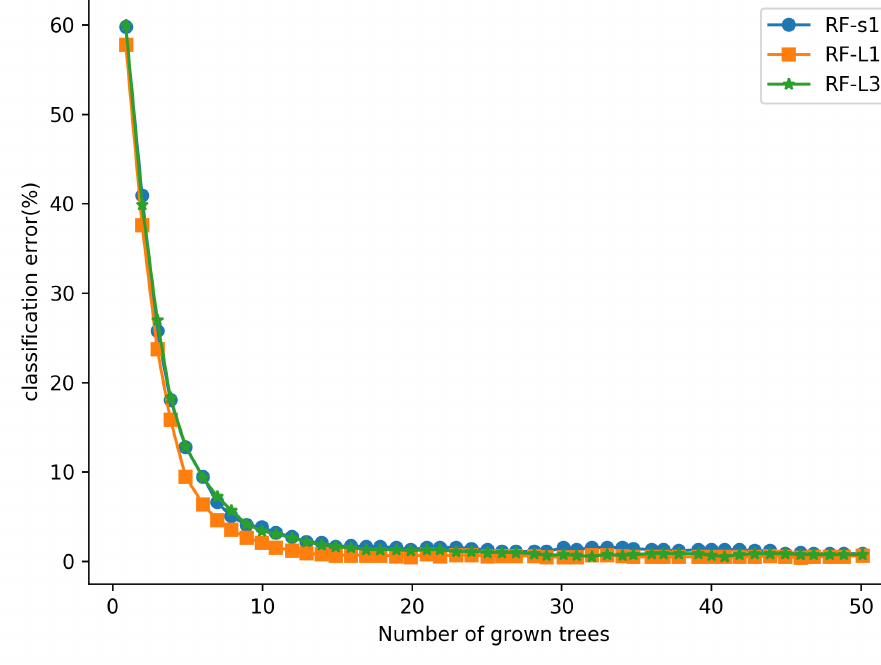
Figure 12. The training error curves of 3 RF